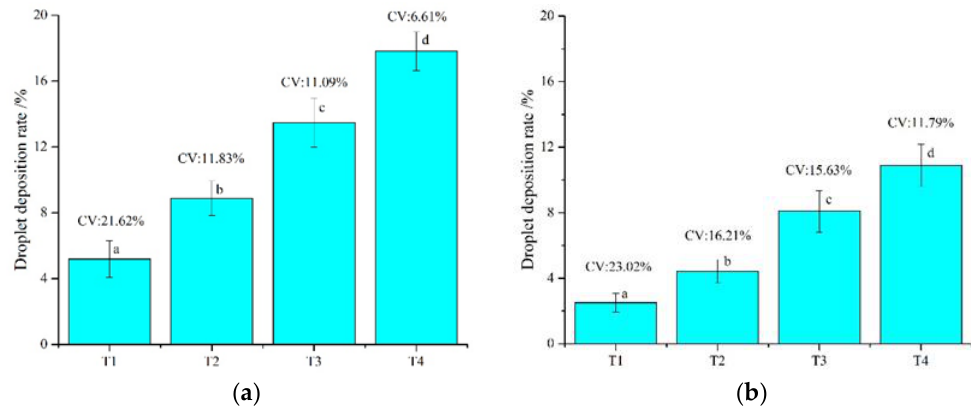
Figure 6. ( a ) Average droplet deposition rate in upper layer; and ( b ) Average droplet deposition rate in lower layer. Bars with different letters are significantly different, Duncan’s test, p -level < 0.05.